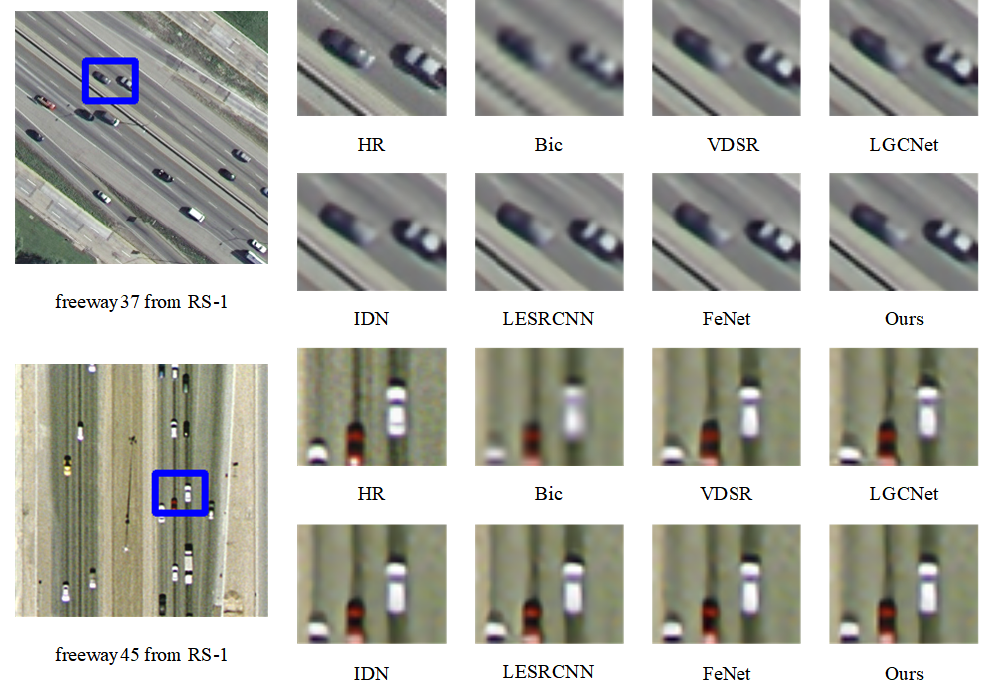
Figure 6. Visualization results of several SR methods and our proposed network, FDENet, on the RS-1 dataset for 3 SR. Zoom in with blue box for best view. ×